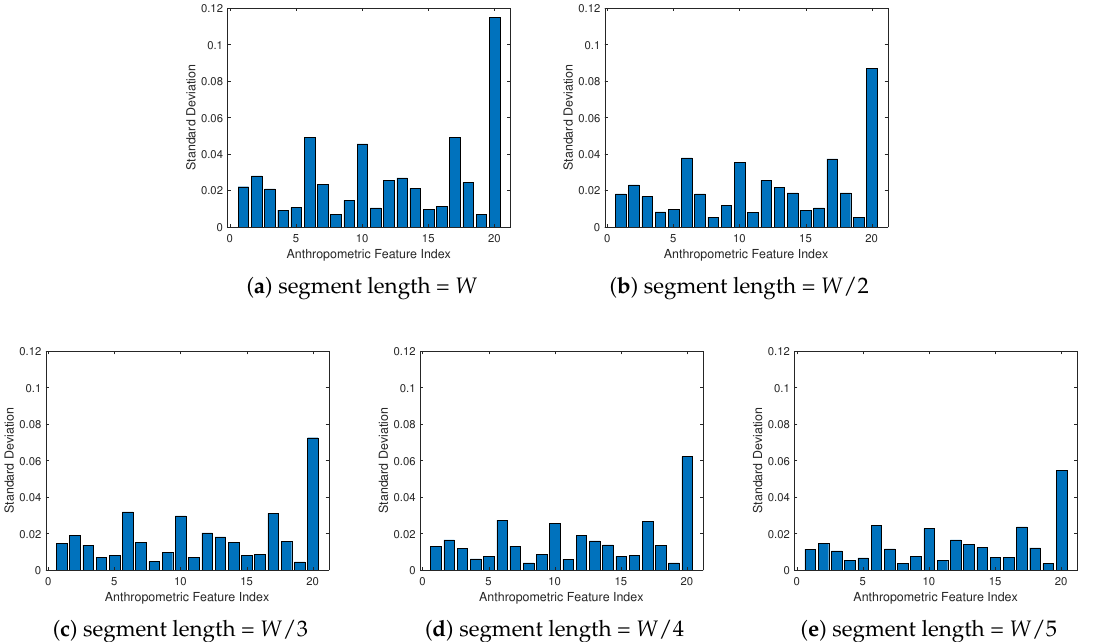
Figure 7. Standard deviations of 20 anthropometric features for long/mid/short-term periods.